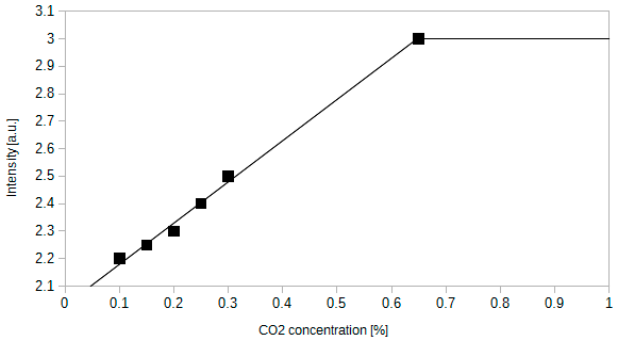
Figure 3. Dependence between the intensity of light transmitted through an optical fibre sensor containing phenol red as an indicator dye and the CO 2 concentration.